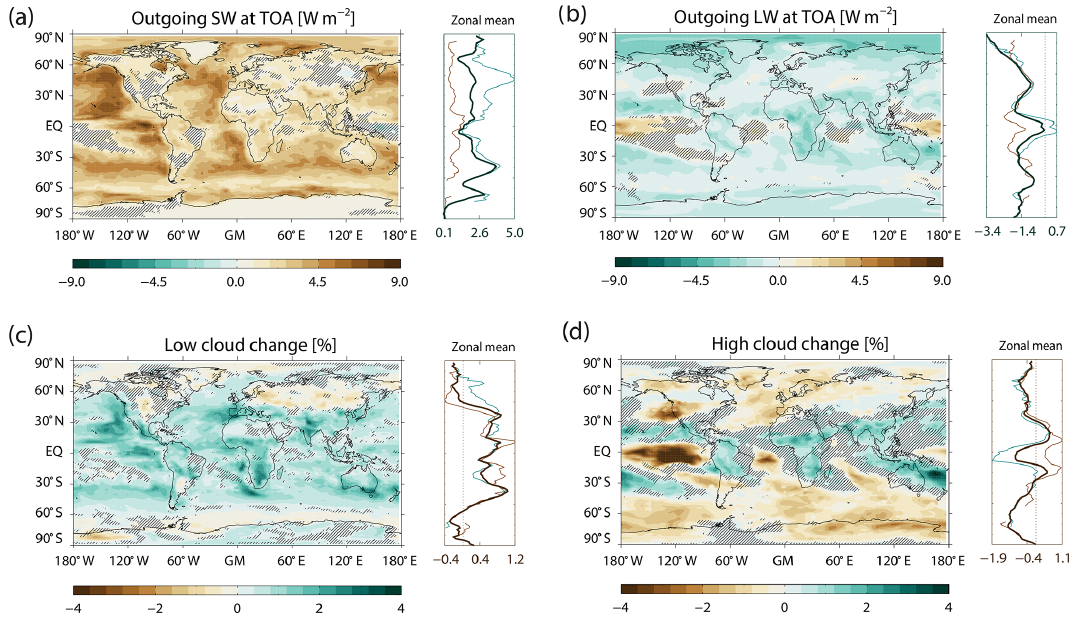
Figure 5. Ensemble median (taken in each grid cell) G4cdnc–RCP4.5 difference of years 2020–2069 of (a) outgoing shortwave radiation at TOA (Wm − 2 ) , (b) outgoing longwave radiation at TOA (Wm − 2 ) , (c) change in low cloud fraction (%), and (d) change in high cloud fraction (%). Hatched areas are grid cells where fewer than 75% of the models agreed on the sign of the change. Zonal averages are given to the right of each panel, where brown and blue lines indicate land-only and ocean-only averages, respectively.